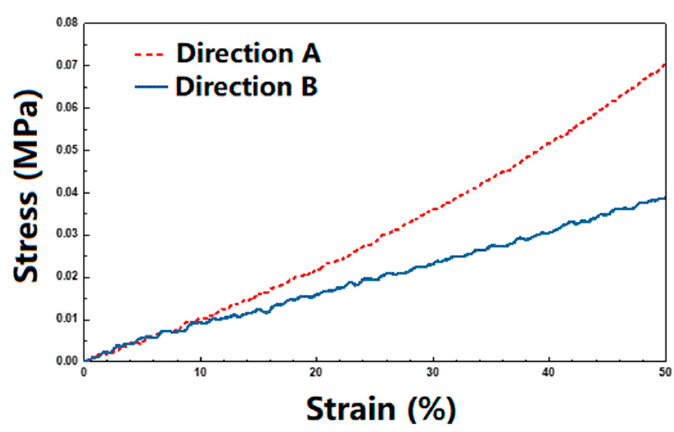
Figure 9. Typical stress versus strain relationships of 1 mm thick commercial two-dimensional (2D) elastic cloth in uniaxial tension along two directions at a strain rate of 10 − 3 / s.